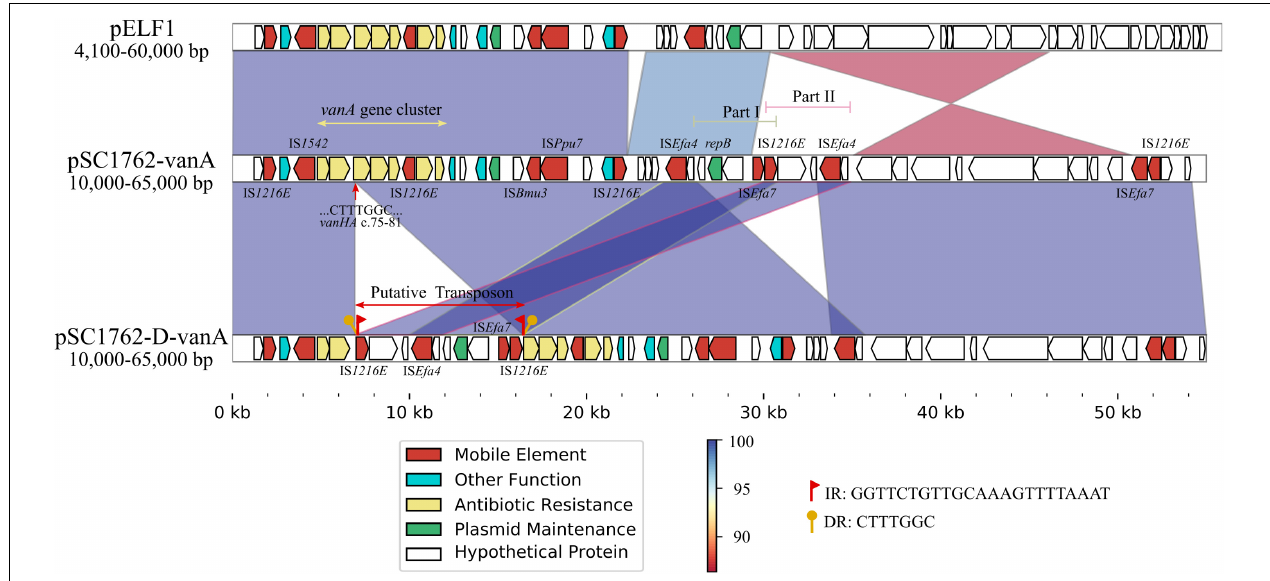
FIGURE 7 | Comparative genetic structures and the genetic environment of the vanA gene cluster. The arrows represent sequence units or genes and are colored based on gene functional classification. Orthologous regions are connected and color coded.